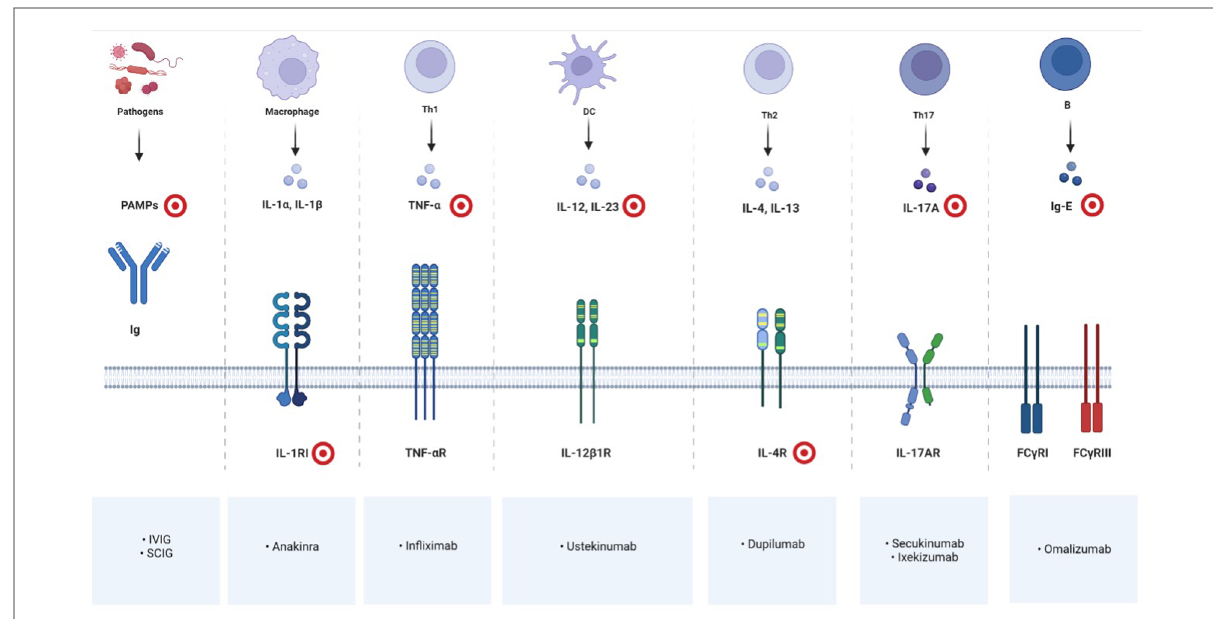
FIGURE 1 Immune cells, mediators and receptors involved in NS and their biological inhibitors; red and white targets showing drug ’ sites of action. Created with